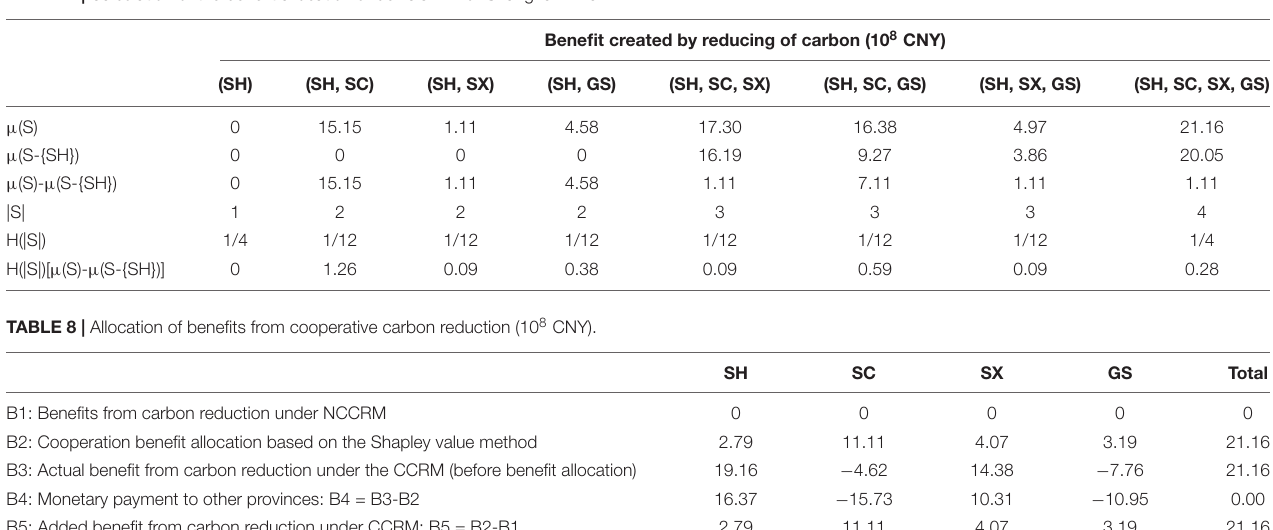
TABLE 7 | Calculation of the benefit allocation under CCRM for Shanghai in 2017.